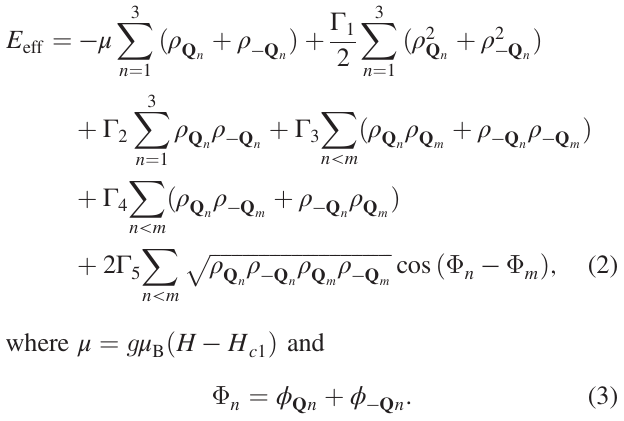
ffiffiffiffiffiffiffiffiffiffi p ρ (cid:1) Q n